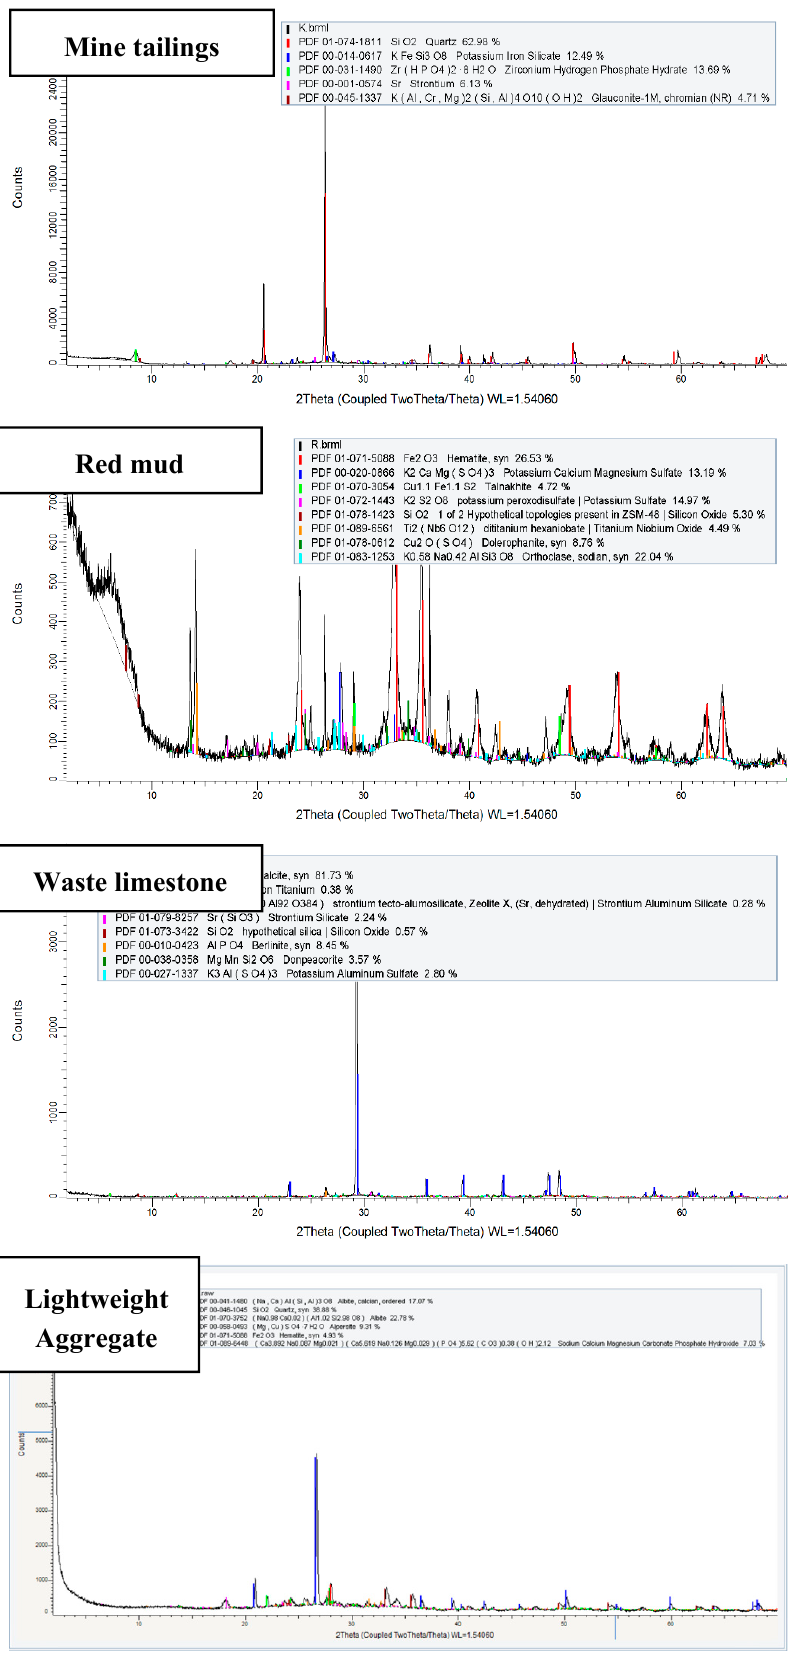
Figure A2. Peak patterns of the mine tailings, red mud, waste limestone, and lightweight aggregate determined using X-ray diffraction